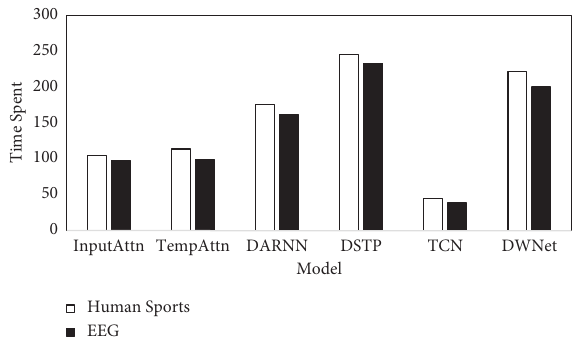
Figure 4: Time spent per 10 epoch in different models and